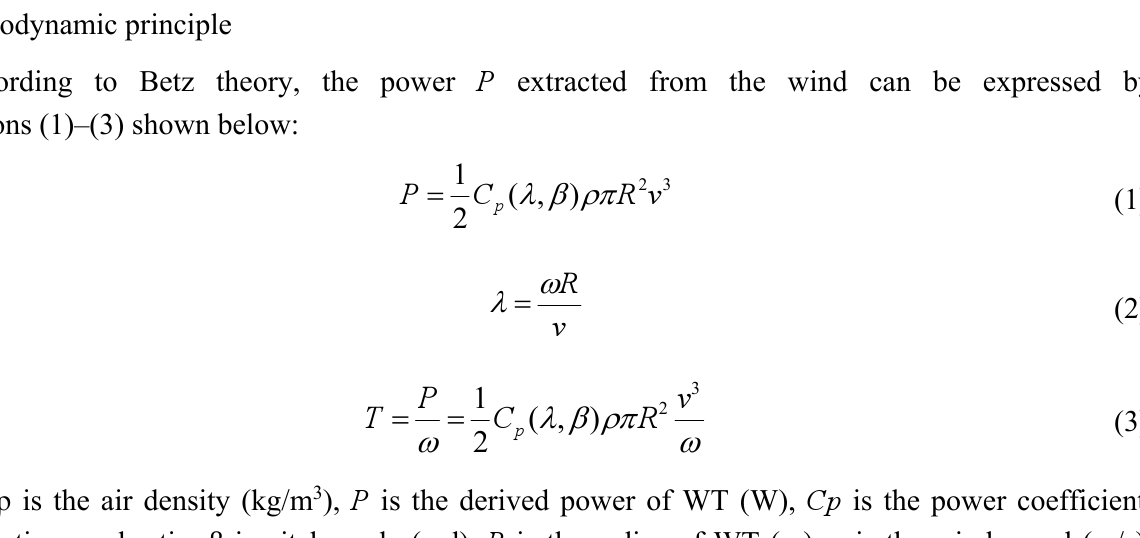
Figure 4. Configuration of a WT with